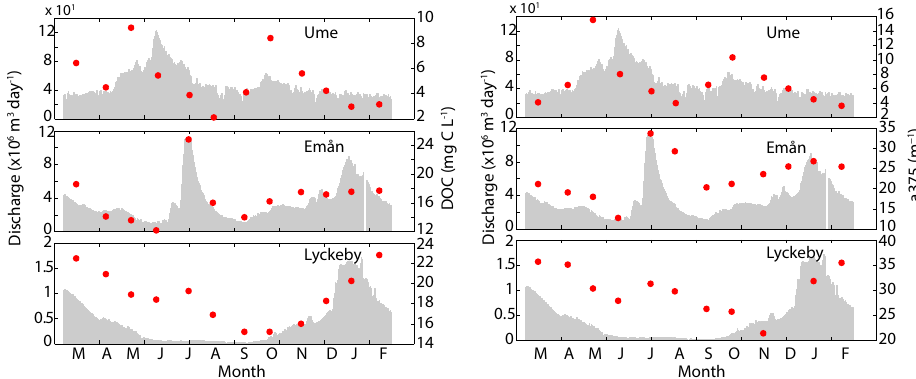
Figure 2. Dissolved organic carbon (left) and CDOM ( a 375 , right) for the three catchments. Red dots are organic matter characteristics, grey bars represent the daily flow on each river at the point of sampling.